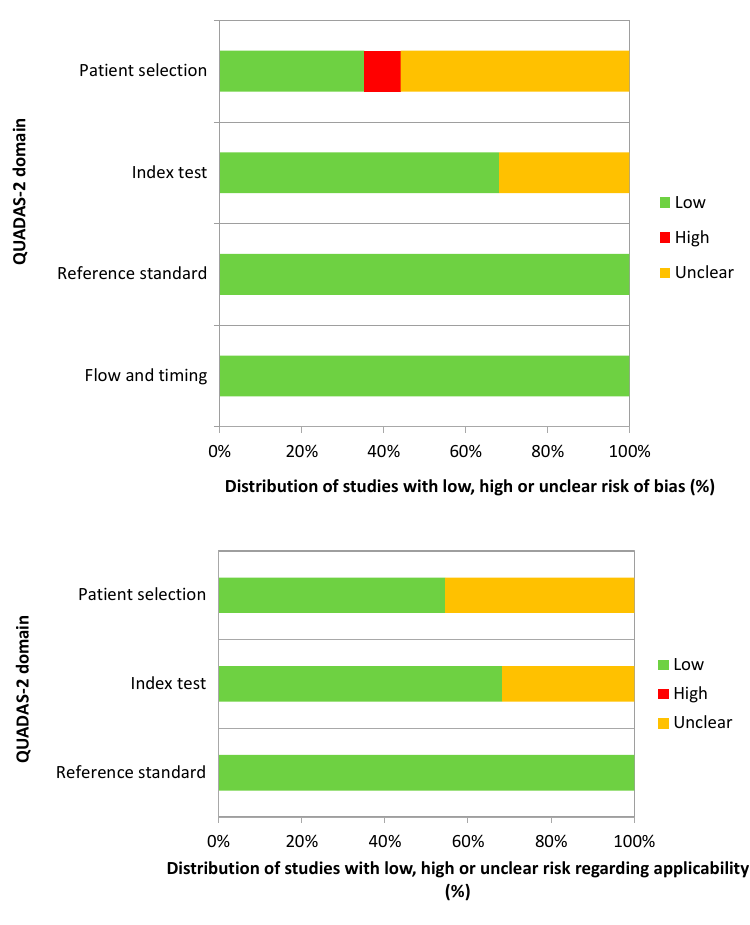
Figure 2. Quality assessment with the QUADAS-2 tool.